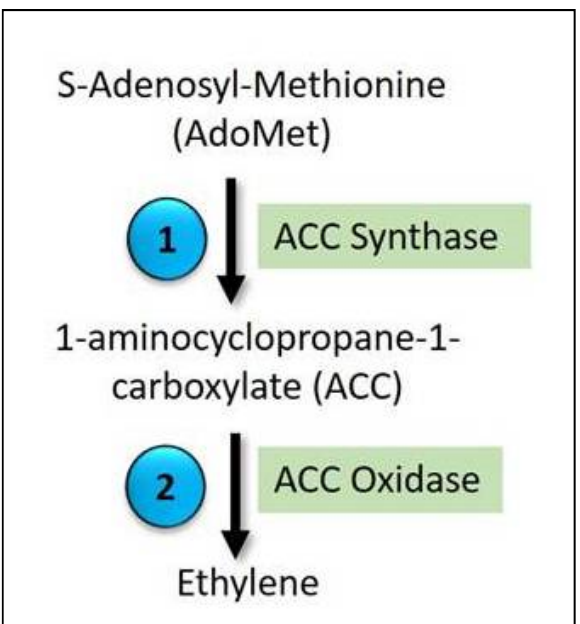
Figure 3. Steps involved in the biosynthesis of ethylene.